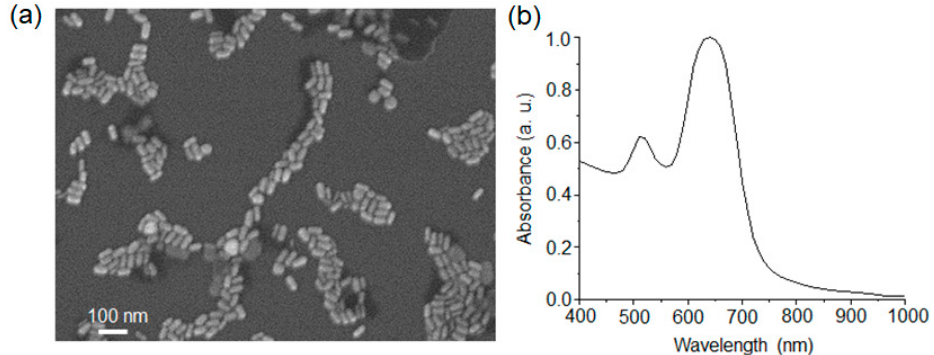
Figure 2. ( a ) SEM image and ( b ) UV–Vis spectrum of the Au